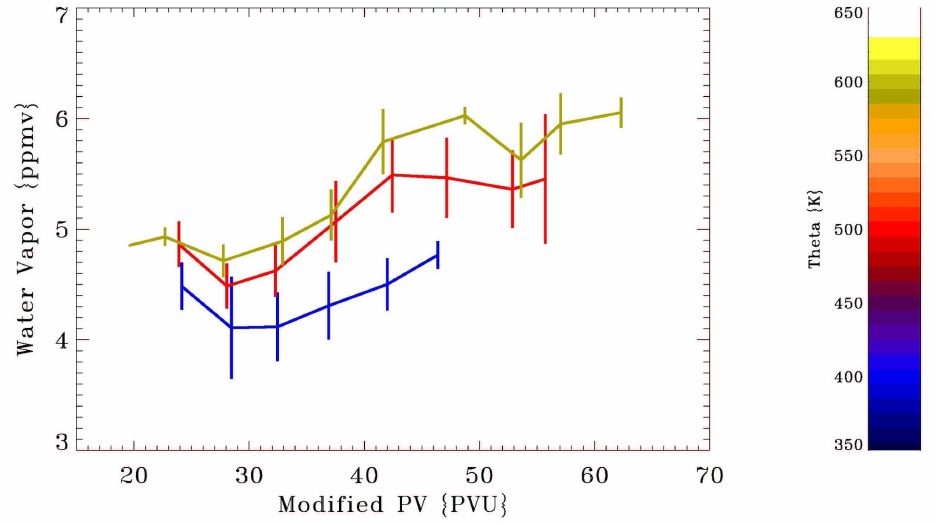
Figure 6. Correlation of water vapour measured by FLASH and modified potential vorticity as simulated by MIMOSA PV runs, for the period February 2004 in the Arctic. The color-coded lines show the MPV- H 2 O correlation for the layers centred around 395 K (blue), 490 K (red), and 595 K (yellow), with the vertical lines indicating the standard deviation for all measurements attributing to the according potential temperature range (350 to 440 K, 440 K to 540 K, and 540 K to 630 K, respectively).